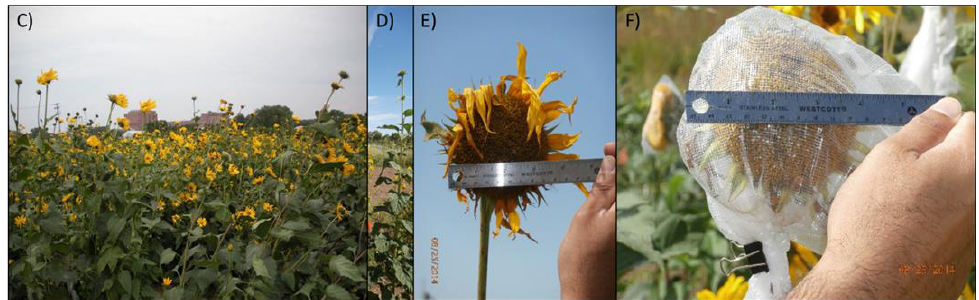
Figure 2. Gain from selection in domestication traits in the interspecific hybrid generation and subsequent generations derived from intermating within the population. ( A ) Decrease in flower number; ( B ) Increase in individual seed weight; ( C ) Multi-branched small headed F 1 populations ( D ) Minimally branched IM 1 F 1 , ( E ) IM 1 F 1 with increased head size, ( F ) IM 1 F 1 with increased head size. P -values represent t -tests between different generations.